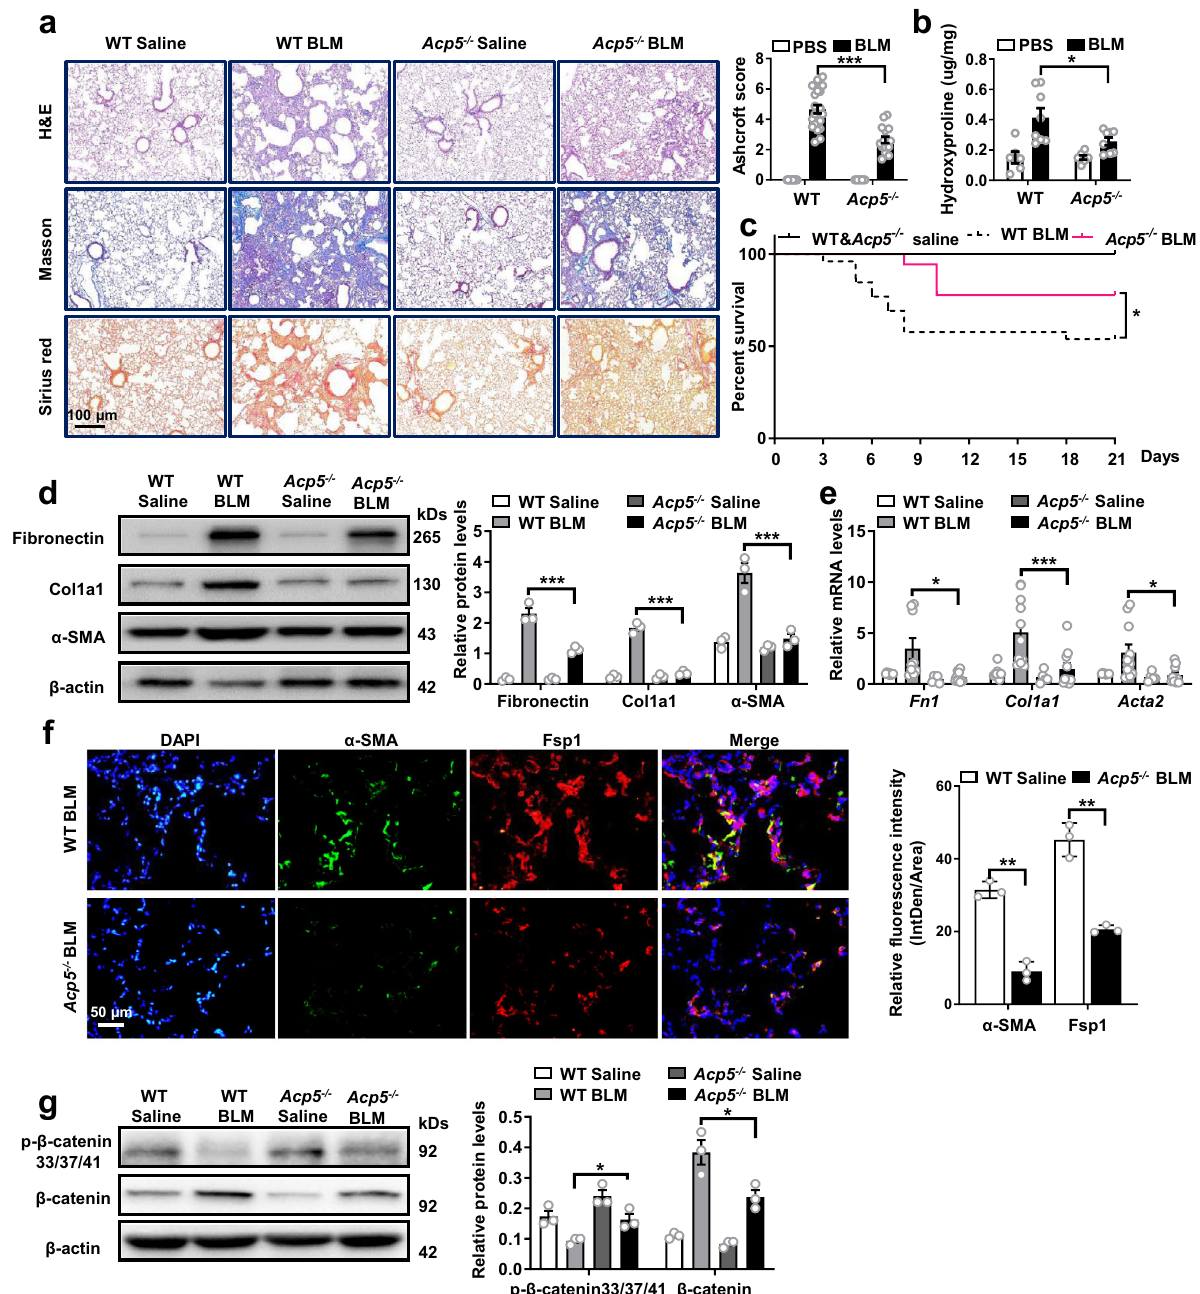
Fig. 6 Comparison of the severity of lung fi brosis between WT and Acp5 − / − mice after BLM induction. a Histological analysis of the severity of lung fi brosis in mice after BLM induction. Left panel: representative images for H&E (top), Masson staining (middle) and Sirius red (bottom). Right panel: A bar graph showed the quantitative mean score of the severity of fi brosis ( p < 0.0001). Images were captured at ×200 magni fi cation (WT Saline n = 18, WT BLM n = 22, Acp5 − / − Saline n = 12, Acp5 − / − BLM n = 16). b Quanti fi cation of hydroxyproline contents in WT and Acp5 − / − mice (WT Saline n = 6, WT BLM n = 8, Acp5 − / − Saline n = 6, Acp5 − / − BLM n = 8, p = 0.0413). c The survival ratio in WT and Acp5 − / − mice after BLM induction (WT Saline n =